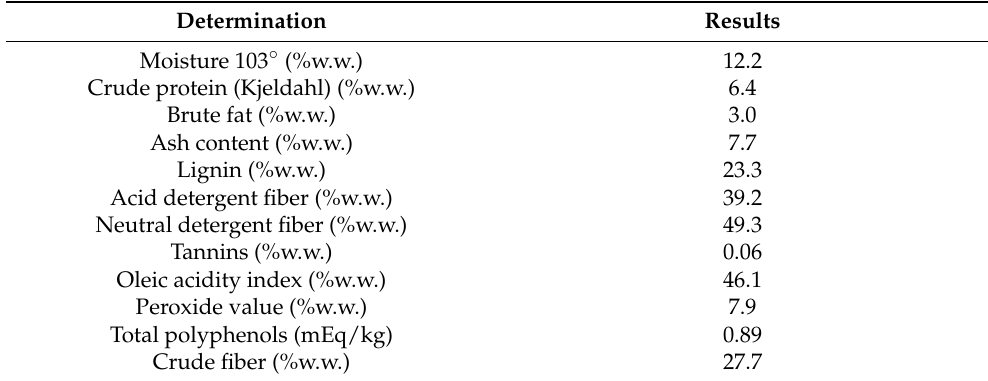
Table 1. Fermented defatted ‘alperujo’ composition